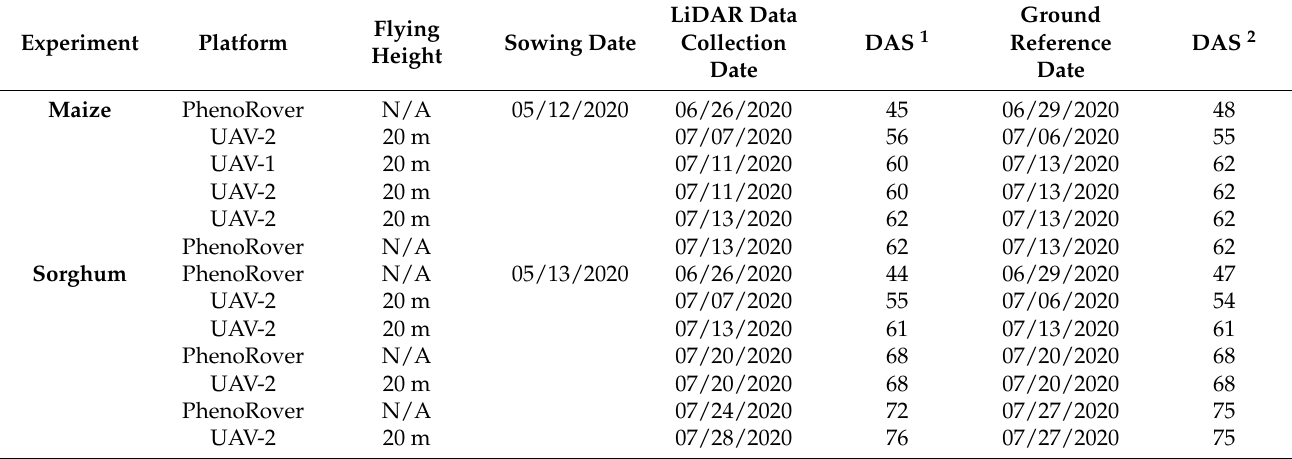
Table 3. LiDAR data and corresponding ground reference data in two experiments with associated DAS.